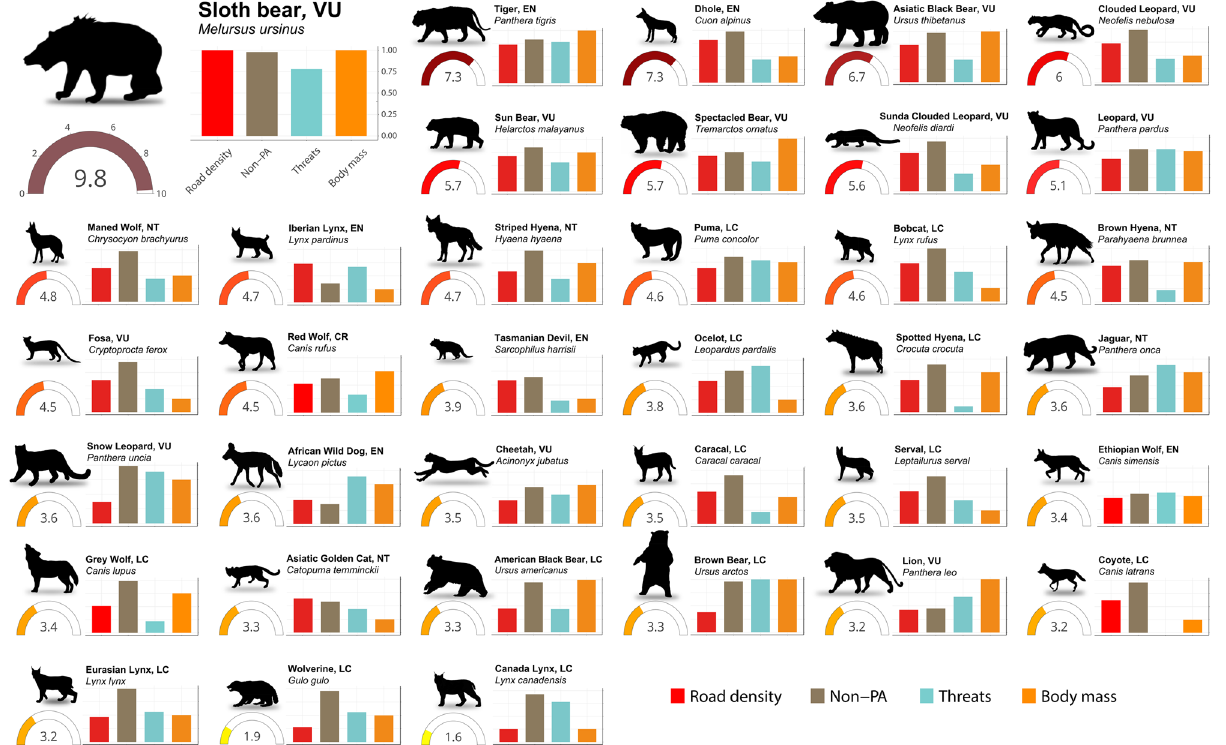
standardized road density, the proportion of species distribution area unprotected, standardized number of IUCN listed threats, and standardized value of the categorized average body mass (i.e., very large (> 100 kg), large (25–100 kg), medium (15–25 kg), small (8–15 kg)). The IUCN conservation of each species 18 is shown. P. uncia, L. pictus and L. canadensis silhouettes were drawn by Gabriela Palomo-Muñoz, all predator silhouettes were acquired from PhyloPic (http:// phylo pic.